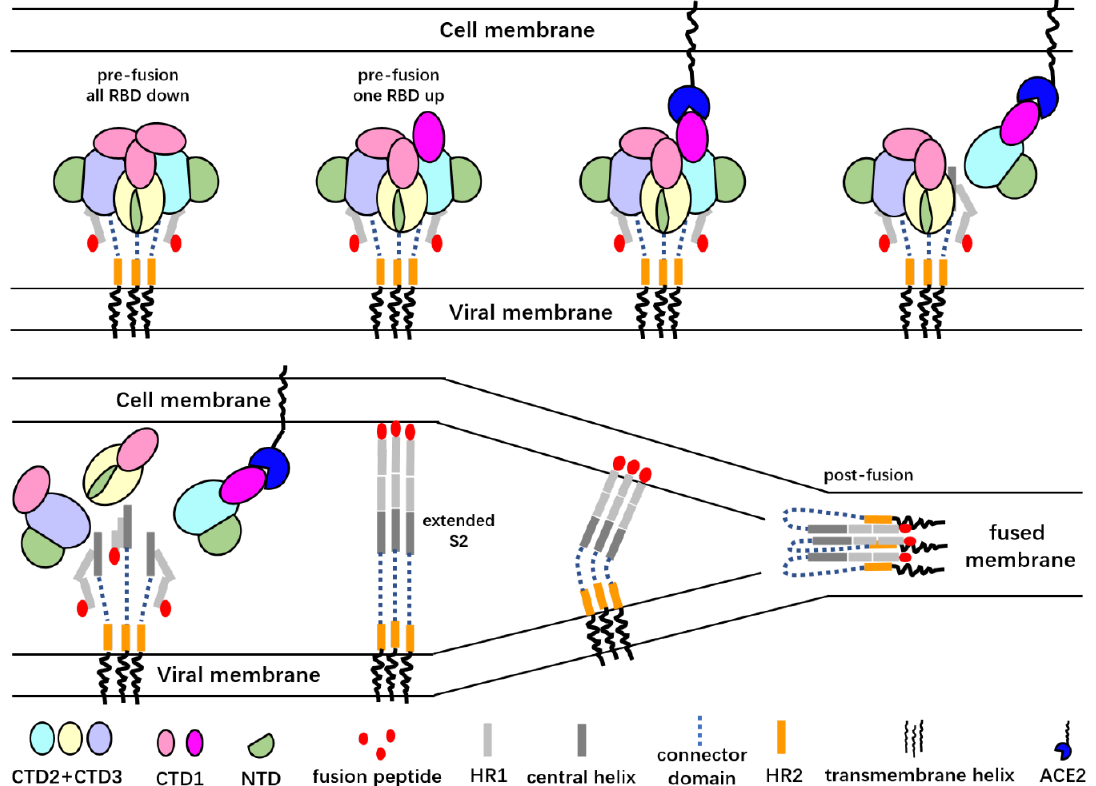
Figure 2. A cartoon representation of the SARS-CoV S glycoprotein-mediated membrane fusion process. Only the “up” RBD is able to bind the angiotensin-converting enzyme 2 (ACE2) receptor, and ACE2 binding promotes the dissociation of the S1 subunits from the trimer spike. Dissociation of the S1 subunits exposes the S2′ cleavage sites and may lead to the extension of S2 subunits and release of the fusion peptide. After the insertion of the fusion peptides into host cell membrane, the α-helical heptad repeat (HR1) regions of the S2 protomers fold back to interact with the HR2 regions to drive the approach of viral and cell membranes. The folded HR1s then interact with HR2s to form a six-helix bundle that brings the viral membrane and host cell membrane close enough to let the membrane fusion happen.